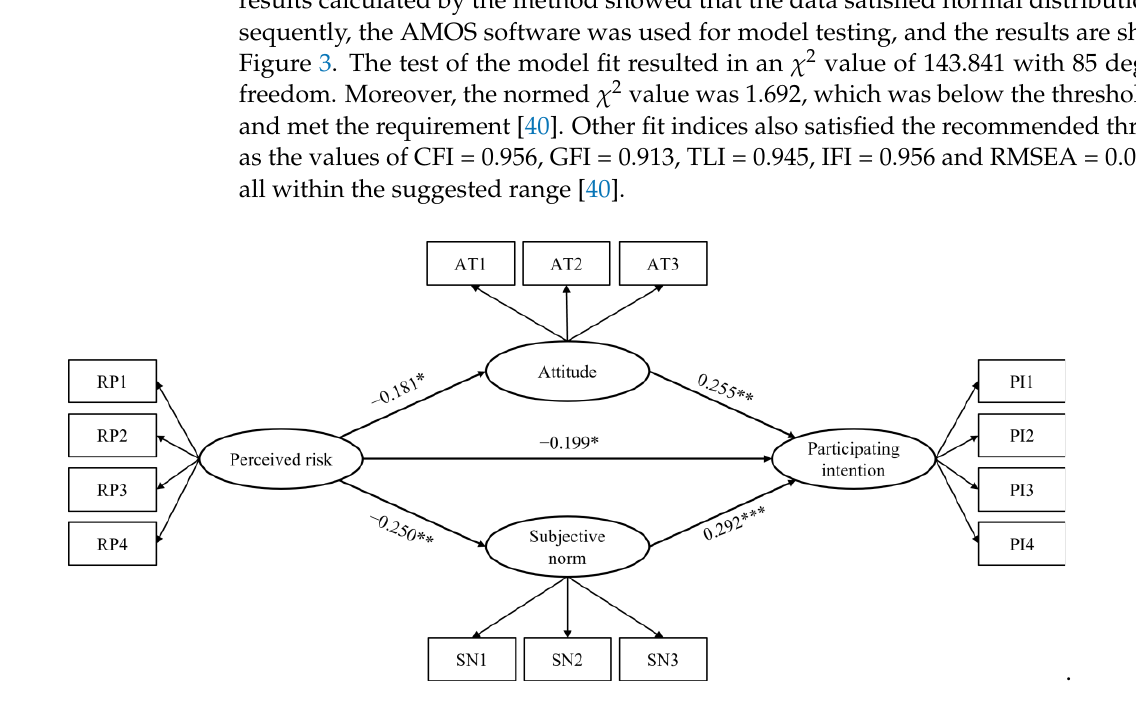
Figure 3. The SEM results. Note: * p < 0.05; ** p < 0.01; and *** p < 0.001.